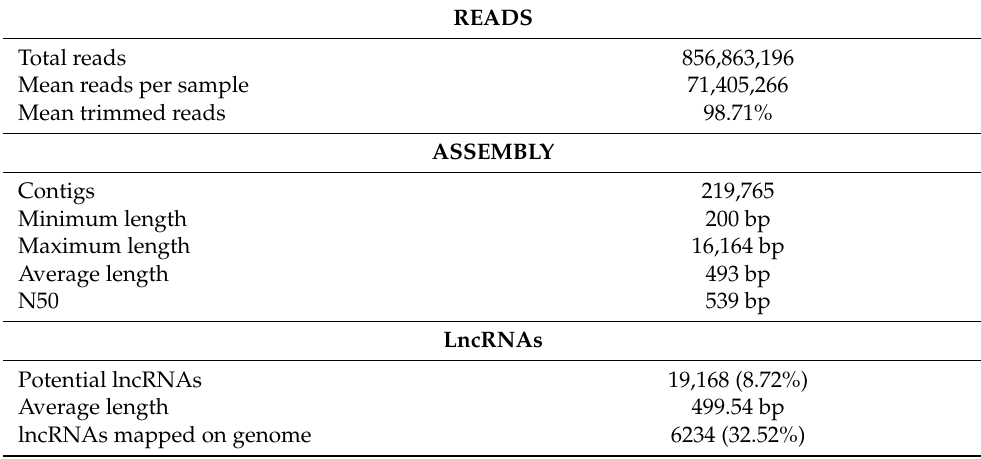
Table 1. Summary of the Illumina sequencing, assembly, and lncRNA